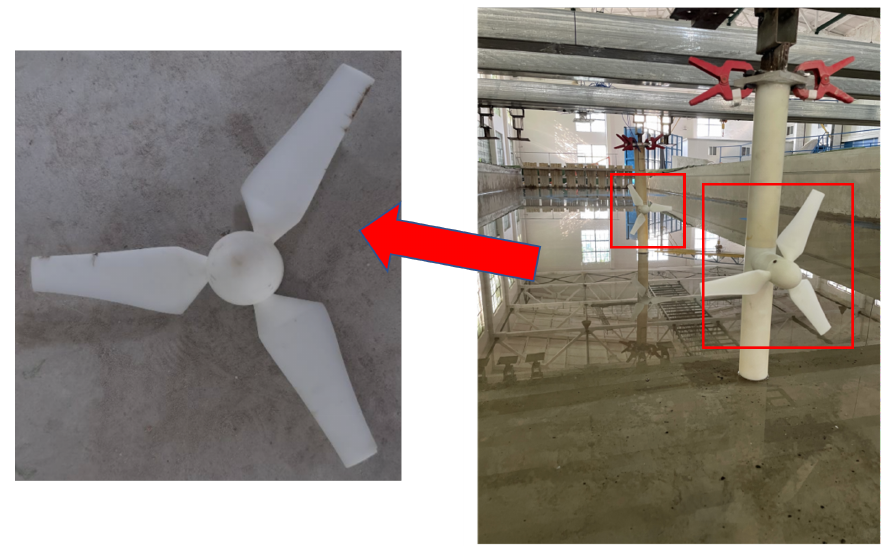
Figure 3. The physical model of the turbine deployed in the experiments.